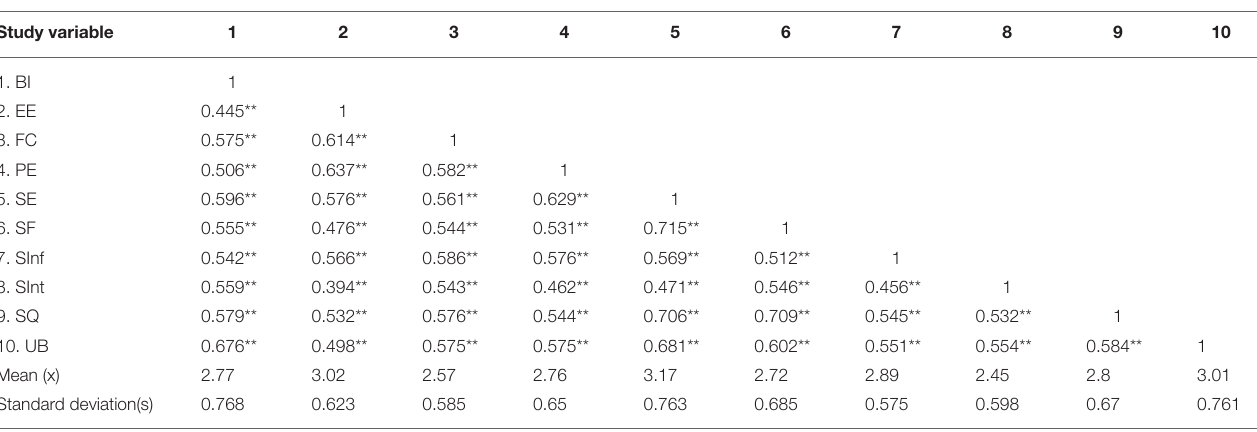
TABLE 2 | Zero-order correlations of the study